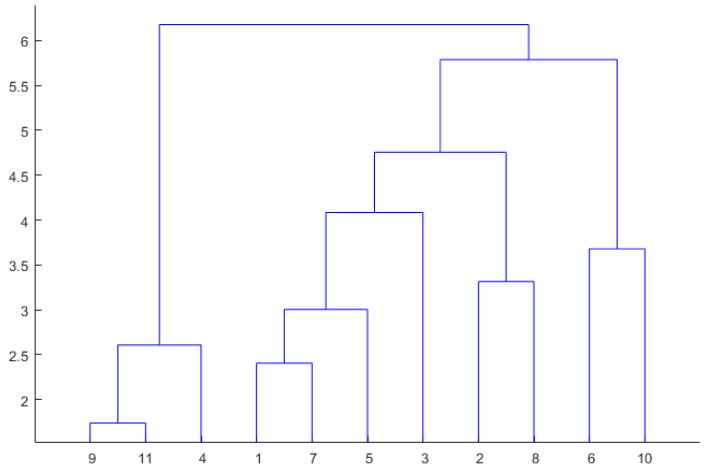
Figure 4. Cluster diagram of various influencing factors.